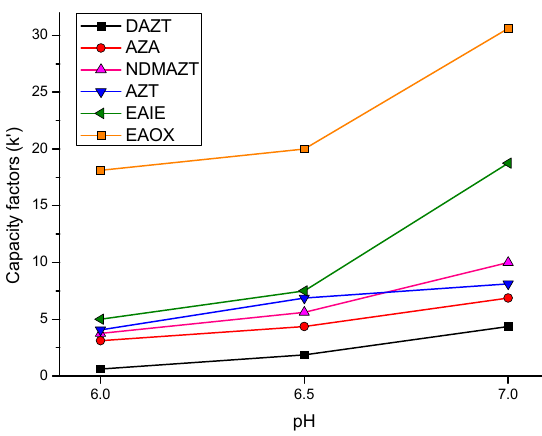
Figure 2. Effect of buffer pH on capacity factors of components of the working mixture.